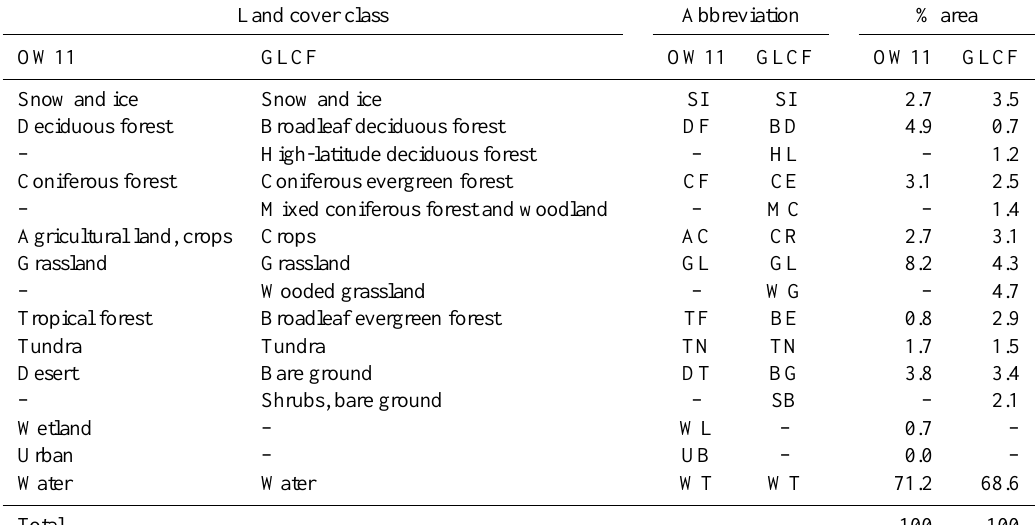
Table 2. Land cover classification for the OW11 and GLCF data sets.